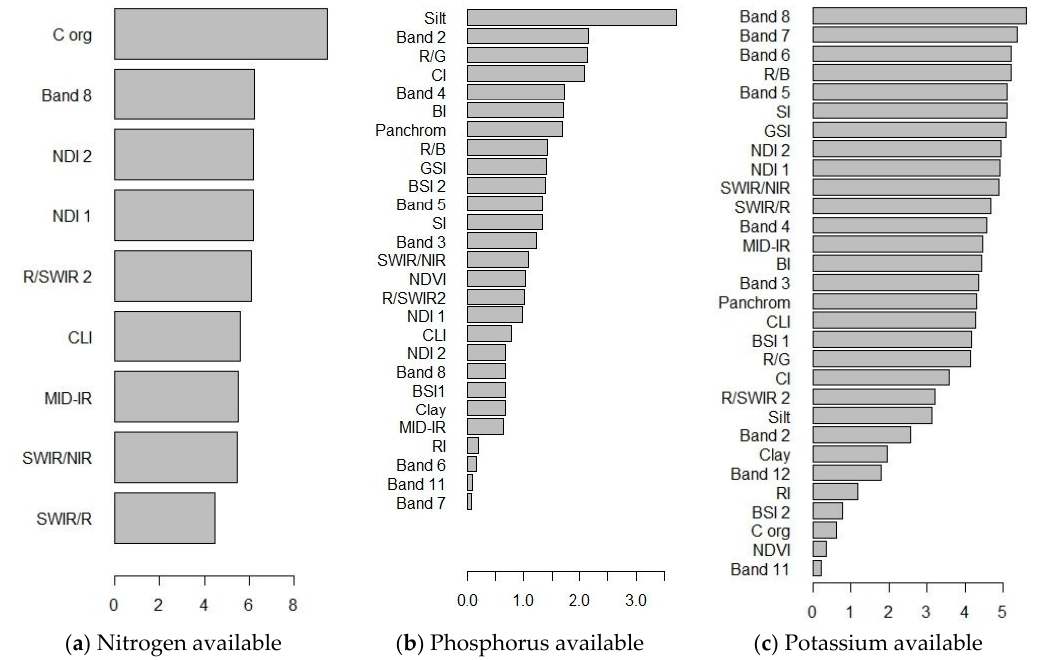
Figure 3. Weight coefficients of predictors of the final models (SVMr Sentinel 2) of nitrogen ( a ), phosphorus ( b ), and potassium ( c ). The larger the weight factor, the greater the impact the predictor has on the target indicator.